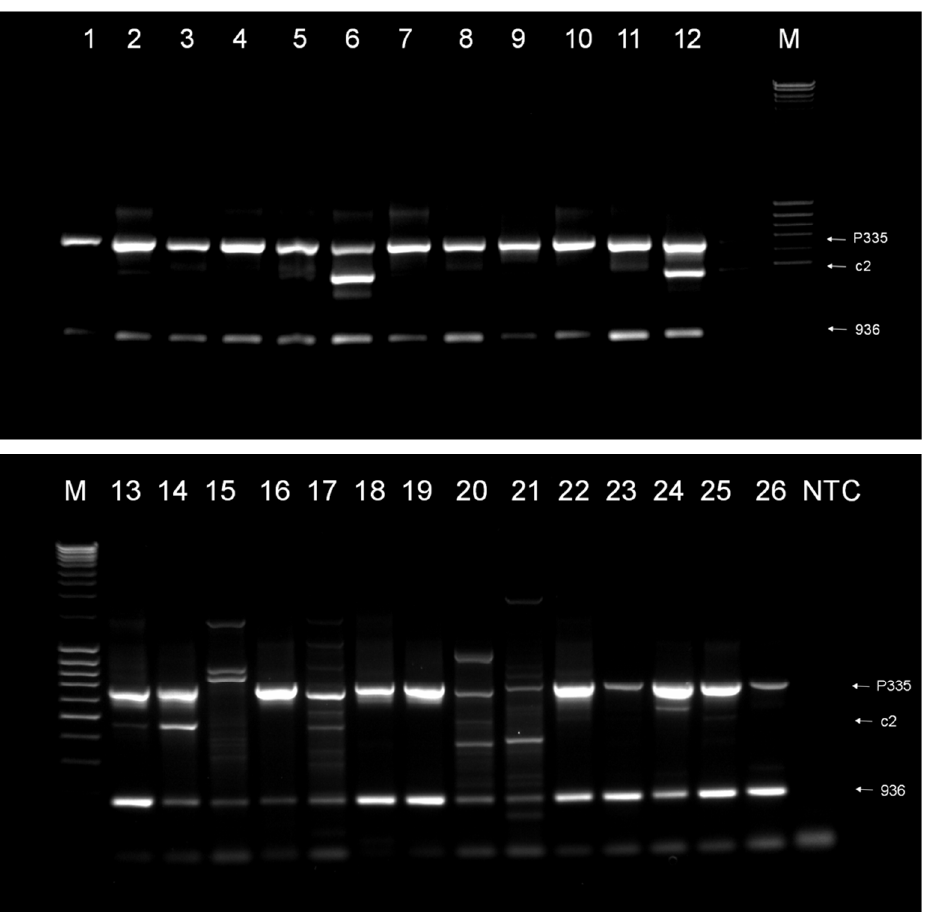
Figure 1. Exemplary multiplex PCR results for detection of lactococcal phages in curd cheeses from dairy plant mass production (lanes 1–12) and spontaneous milk fermentation from in-house cheese production (lanes 13–26). Arrows indicate positions of specific amplicons for P335, c2, and 936 Lactococcus phage types (M—molecular weight marker, NTC—non-template